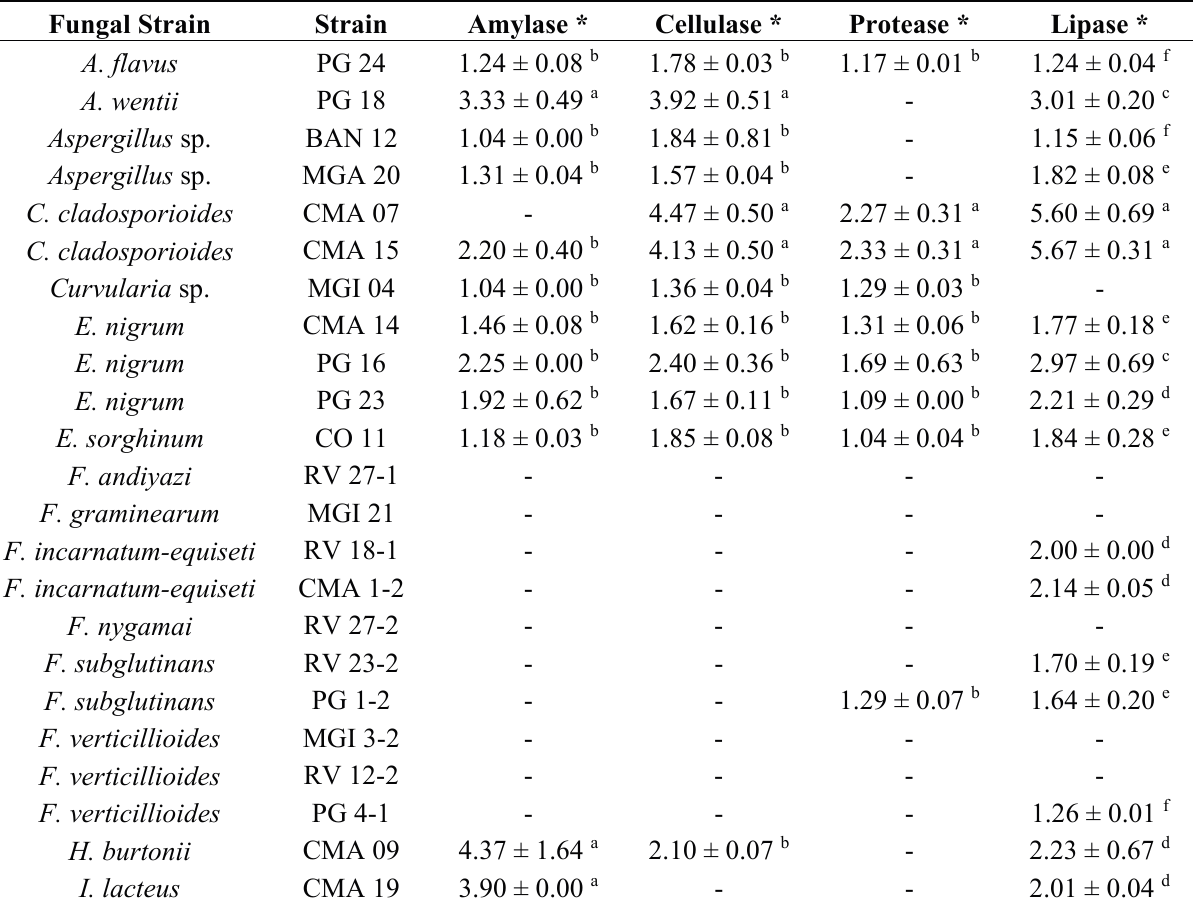
Figure 2. Petri dishes with defined substrate media for detection of the enzyme activities. ( A ) Amylolytic activity. Nutrient agar containing soluble starch. A. wentii -PG 18; ( B ) Cellulolytic activity. Medium containing microcrystalline cellulose. P. digitatum -RV 06; ( C ) Proteolytic activity. Medium containing milk casein. C. cladosporioides -CMA 15; ( D ) Lipolytic activity. Medium containing Tween 20 and CaCl 2 . E. nigrum -PG 16. Table 2. Enzymatic Index of hydrolytic enzymes production by fungi isolated from maize with rot